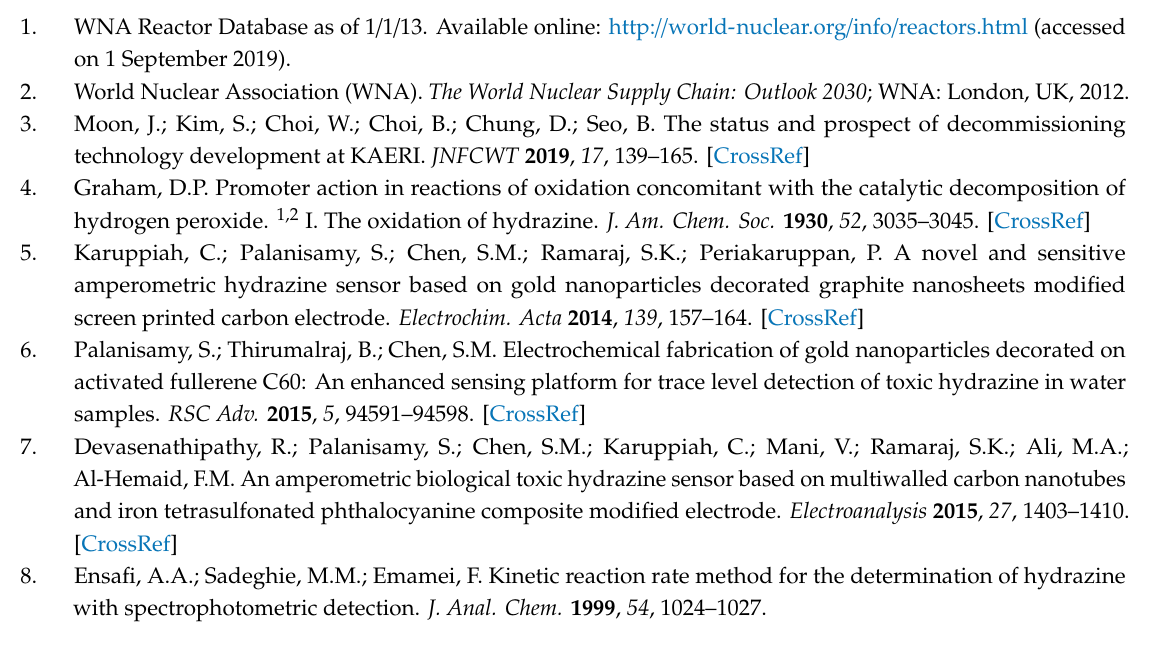
Figure S1: Time sequential images of color change in the presence of Fe 2 + ; Figure S2: Time sequential images of color change in the presence of Fe 3 +